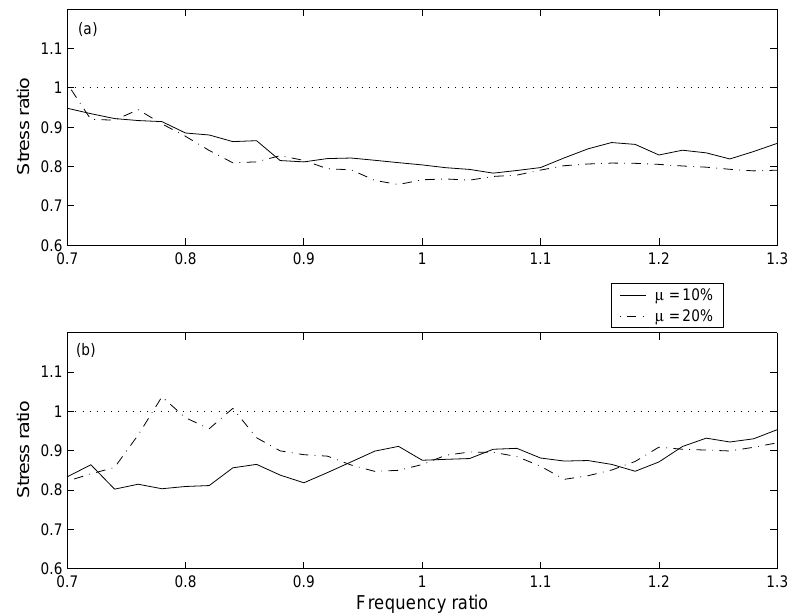
Fig. 3. Ratio of maximum stress as a function of frequency ratio for (a) Northridge earthquake, and (b) El Centro earthquake. system. The lower stress ratio values in the plots imply better control effectiveness. Figure 3(a) is for the Northridge earthquake motion with maximum ground acceleration of 0.843 g. Figure 3(b) is for the El Centro earthquake